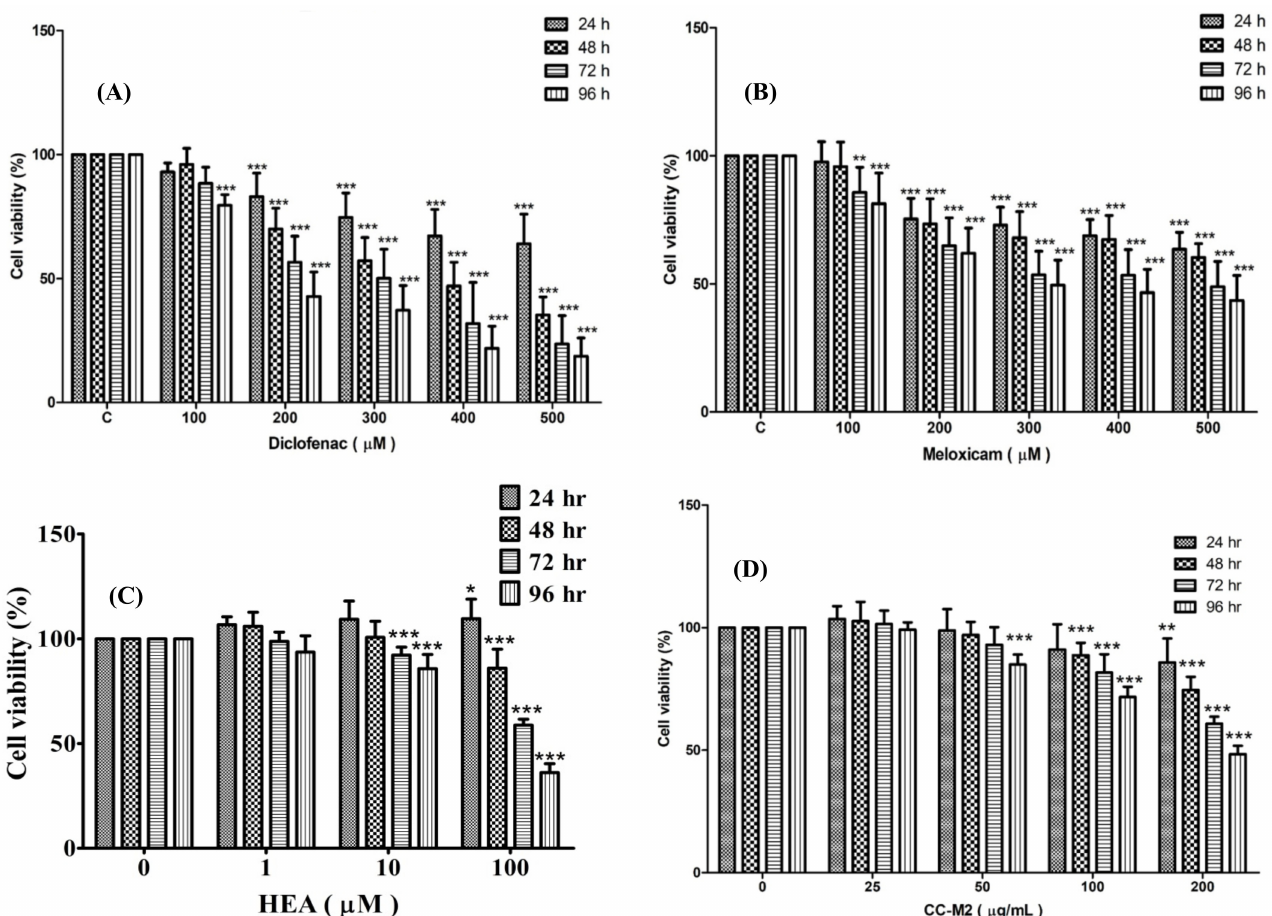
Figure 2. The percent cell viability of HK–2 cells treated with DCF, MXC, HEA, and CC-M2 fraction. HK-cells were treated with DCF ( A ); MXC ( B ); HEA ( C ), and CC-M2 fraction ( D ), respectively. The cell viability was measured at 24, 48, 72 and 96 h, respectively, after treatment. Values are expressed as mean ± SD ( n = 3). * p < 0.05, ** p < 0.01 and *** p < 0.001 compared with